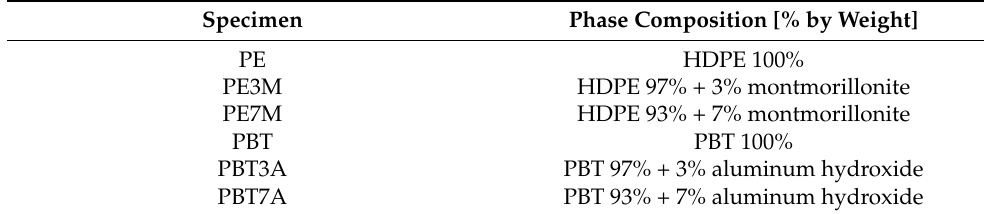
Table 1. Phase composition of the specimens used for testing.